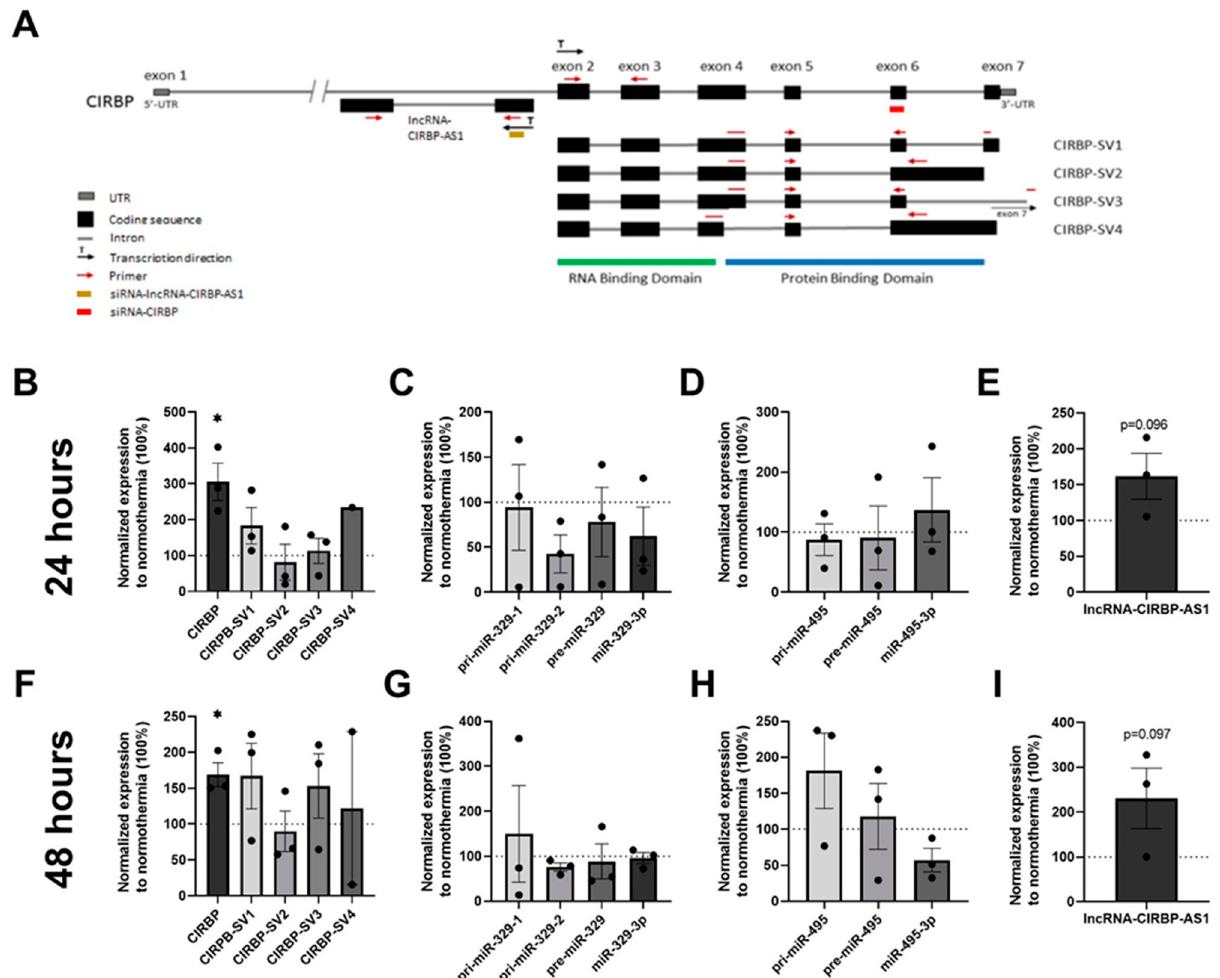
Figure 4. Cold-inducible RNA-binding protein gene ( CIRBP ) expression under hypothermia for 24 and 48 h: ( A ) Schematic representation of the CIRBP gene, its splice variants, and lncRNA- CIRBP -AS1 with the binding sites of primers and small interfering RNA (siRNA) indicated. Human umbilical vein endothelial cells (HUVECs) were cultured under hypothermic conditions (32 ◦ C) for 24 and 48 h, and ( B , F ) CIRBP and CIRBP splice variant ( CIRBP-SV ) expression levels were measured and normalized to GAPDH. CIRBP -SV4 expression was below the detection limit in several experiments; ( C , D , G , H ) primary microRNA (pri-miR), precursor microRNA (pre-miR), and mature microRNA expression levels of miR-329 and miR-495 were measured and normalized to U6; ( E , I ) CIRBP gene antisense long non-coding RNA (lncRNA- CIRBP -AS1) expression level was measured and normalized to GAPDH. Data are shown as the relative expression compared to the normothermic group, presented as the mean ± SEM; * p < 0.05 by one-sample t -tests (one-tail).